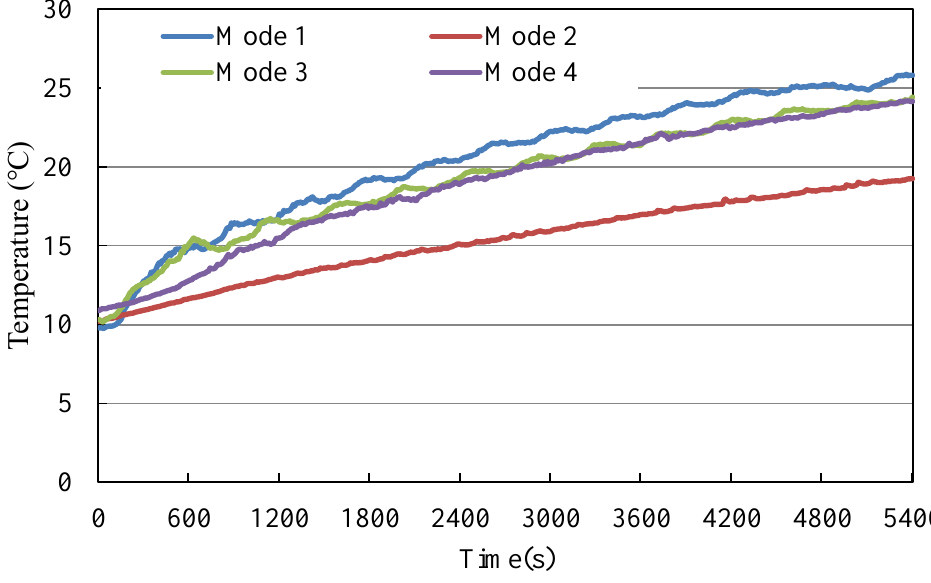
Figure 9. Air temperature (80 cm from floor surface).